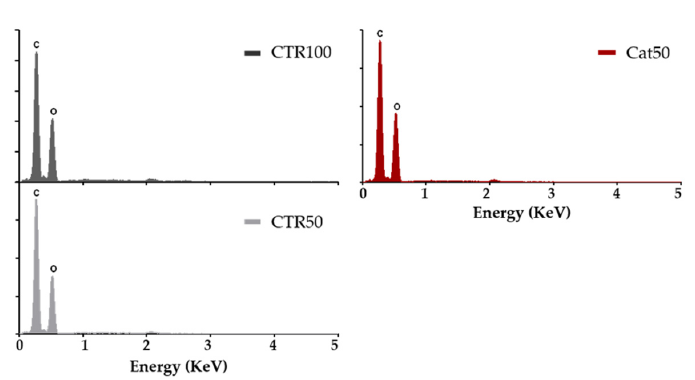
Figure A6. Representative histograms of the LbL films’ dry adhesion force, constructed from 100 force-distance curves registered across the surface. The mean adhesion value of each film formulation is indicated.